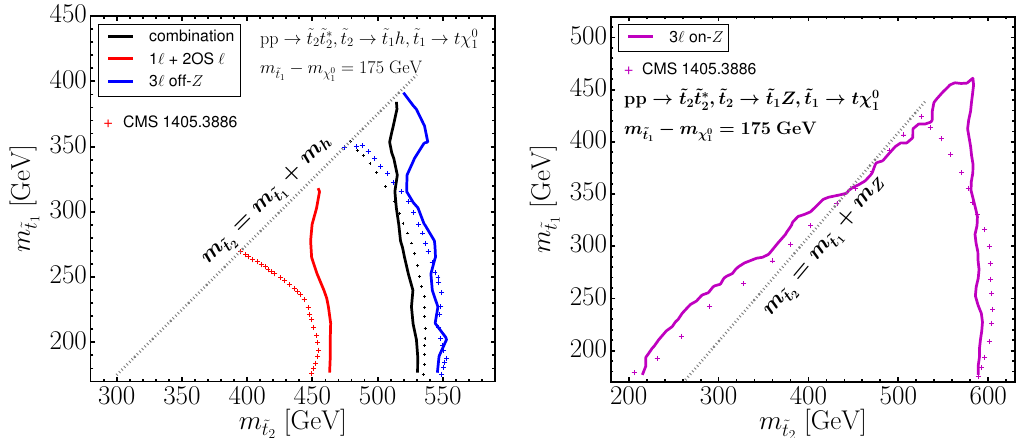
Figure 2 . The comparison of 95% C.L. upper limits between CMS results (\+" symbol lines) and our simulations (solid lines) for the LHC ~ t 2 pair production, with ~ t 2 m LSP mass is (cid:12)xed to be m ~ = 175 GeV. BR(~ t 2 (cid:31) 0 1 t 1 (cid:0) ~ t and BR(~ t 2 1 Z ) = 100% is assumed for the right panel. Results [19] from the 8 TeV LHC with ! 19.5 fb (cid:0) 1 are used